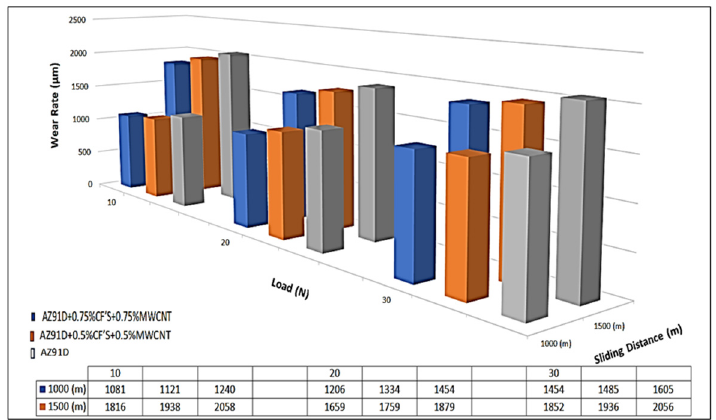
Figure 8. Wear rate of the Mg AZ91D hybrid composite with varying weight percentages of CF and MWCNT reinforcements. MWCNT